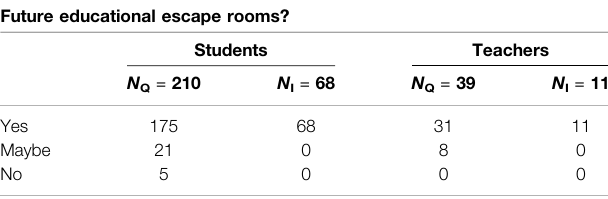
TABLE 6 | The number of students and teachers who want to participate in future educational Escape Rooms and the teachers ’ boundary conditions for its implementation in their